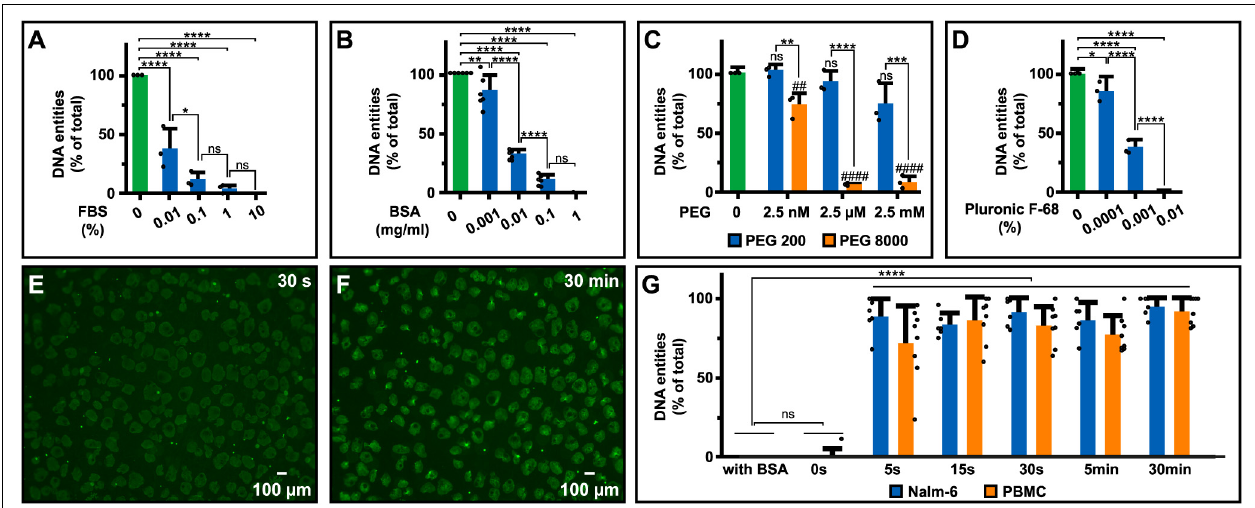
FIGURE 4 | Extracellular DNA upon various treatments. Impact of (A) FBS ( N = 3), (B) BSA ( N = 6), (C) PEG ( N = 3), and (D) Pluronic F-68 ( N = 3) on DNA release from Nalm-6 cells in RPMI-1640 with additives of indicated concentrations for 30 min prior to staining of extracellular DNA and microscopy analyses. The amount of DNA entities in the serum-free control sample was considered 100% to which all samples were compared. (E,F) Extracellular DNA released from 100,000 Nalm-6 cells visualized in supernatants from the same sample after less than 30 s (E) and 30 min (F) upon serum withdrawal imaged using 4 × objective. (G) Assessment of the timeframe for DNA release upon serum removal. Nalm-6 cells ( N = 6) and PBMC ( N = 8) were incubated in PBS for indicated times before BSA to a final concentration of 1 mg/ml was added. The time point with the highest amount of released DNA entities in each experiment was considered 100% to which all samples were compared. Filled circles in panels (A–D,G) represent the mean for each individual experiment and error bars represent standard deviations calculated using the mean for all biological replicas (A,B,G) or all included technical replicas for the three independent experiments (C,D) . Statistical analyses were done using one-way ANOVA followed by Turkey’s multiple comparisons test (A–D) and Dunnett’s multiple comparisons test (G) . * P < 0.05, **/ ## P < 0.01, *** P < 0.001, ****/ #### P <